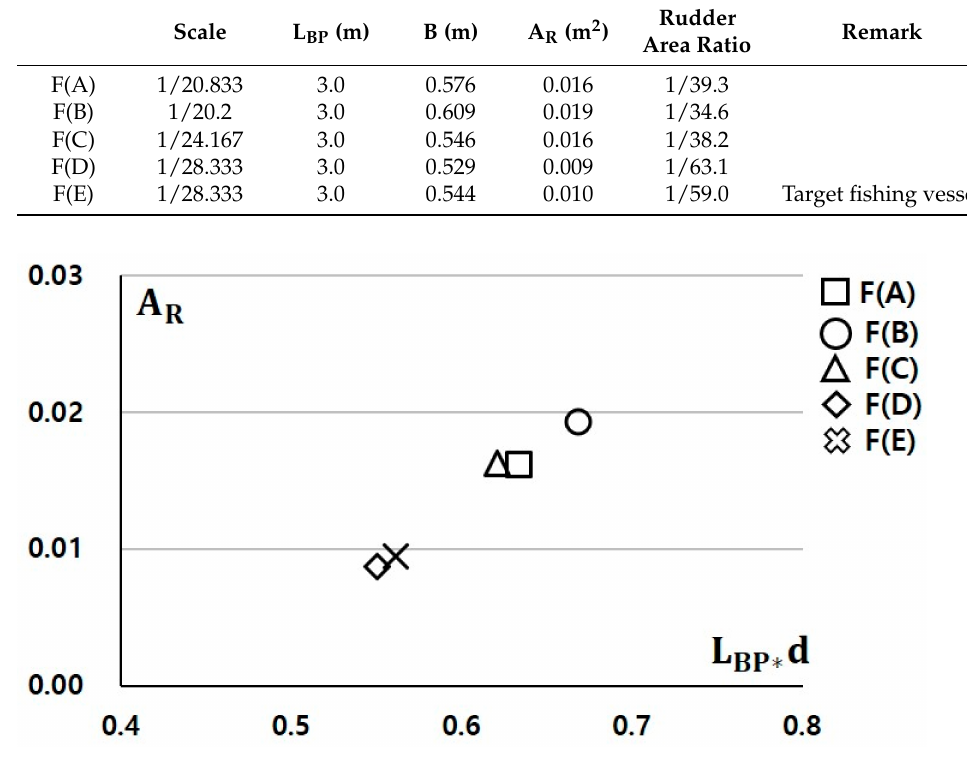
Figure 8. Rudder area ratio of model fishing